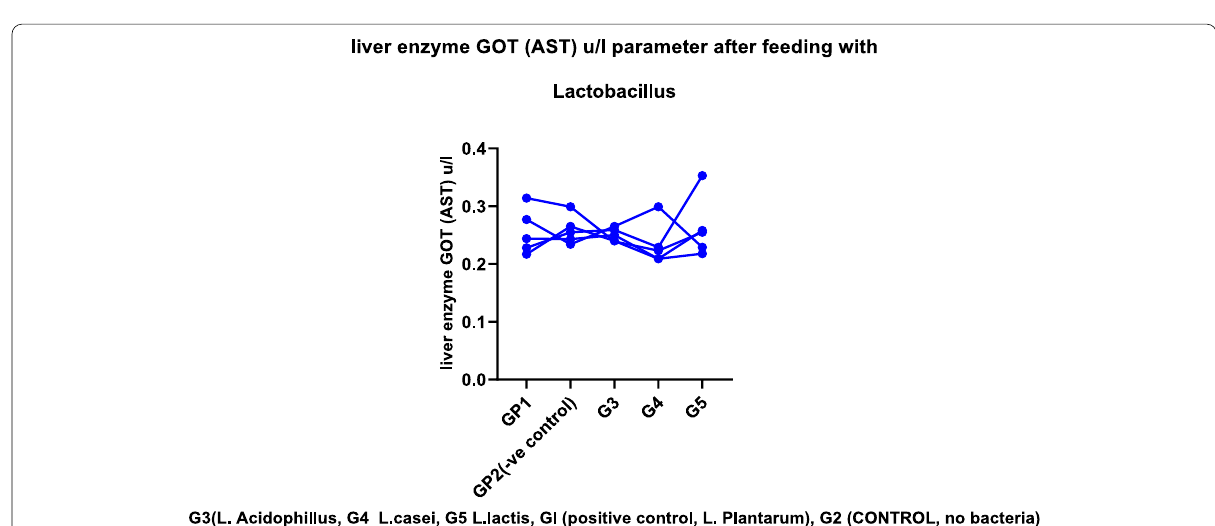
Fig. 7 Liver enzyme GOT (AST) μ /l parameter after feeding with Lactobacillus sp